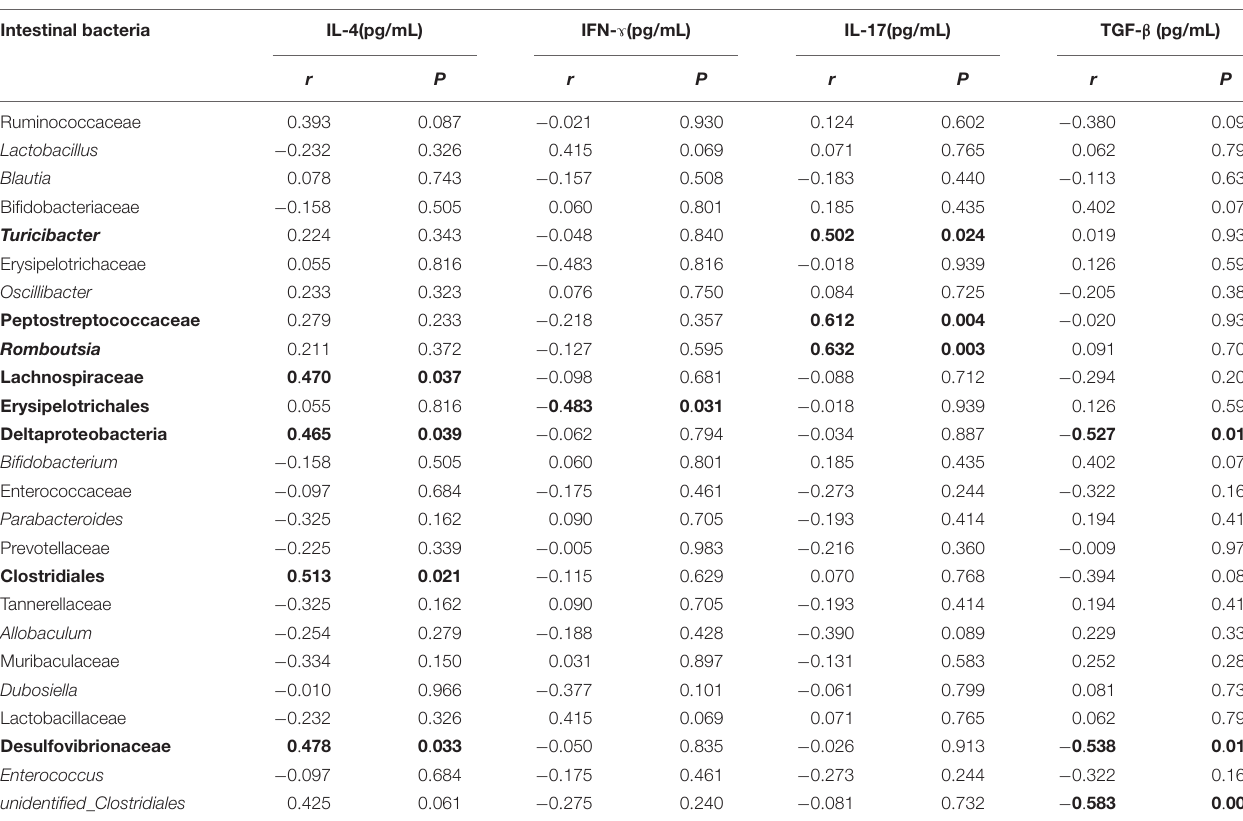
TABLE 3 | Pearson correlation coefficients between intestinal bacteria and cytokines in BALF. Intestinal